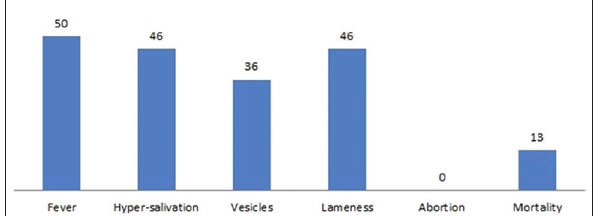
Figure-1: Number of breeders who have seen clinical Table-1: Clinical signs mentioned by breeders in cattle and mixed (cattle and sheep) farms. Signs observed by the Number of breeders who have breeders seen signs in cattle Fever Abortion 00